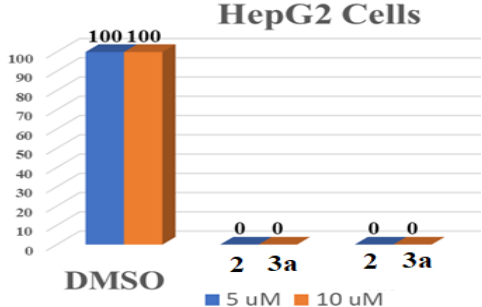
Figure 3. Compounds 2 and 3a inhibit colony formation by Hep-G2 cells.